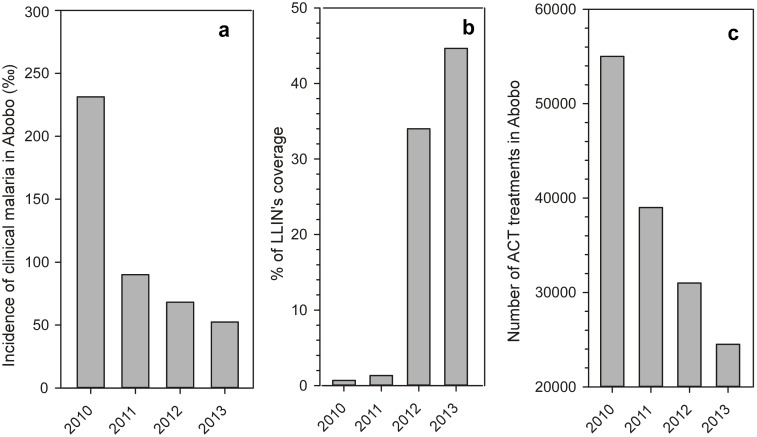
Indicators of malaria prevention measures in Abobo from 2010 to 2013.Longitudinal annual profiles of incidence of clinical malaria (a), percentage of population coverage by LLIN distribution (b) and number of ACT treatments distributed (c) are shown as histogram plots. These indicators illustrate the substantial increase of prevention measures from 2010 to 2013 (data from RASS 2013—Rapport Annuel des Service de Sante, Ministère de la Sante et de la Lutte contre le SIDA, Côte Ivoire).